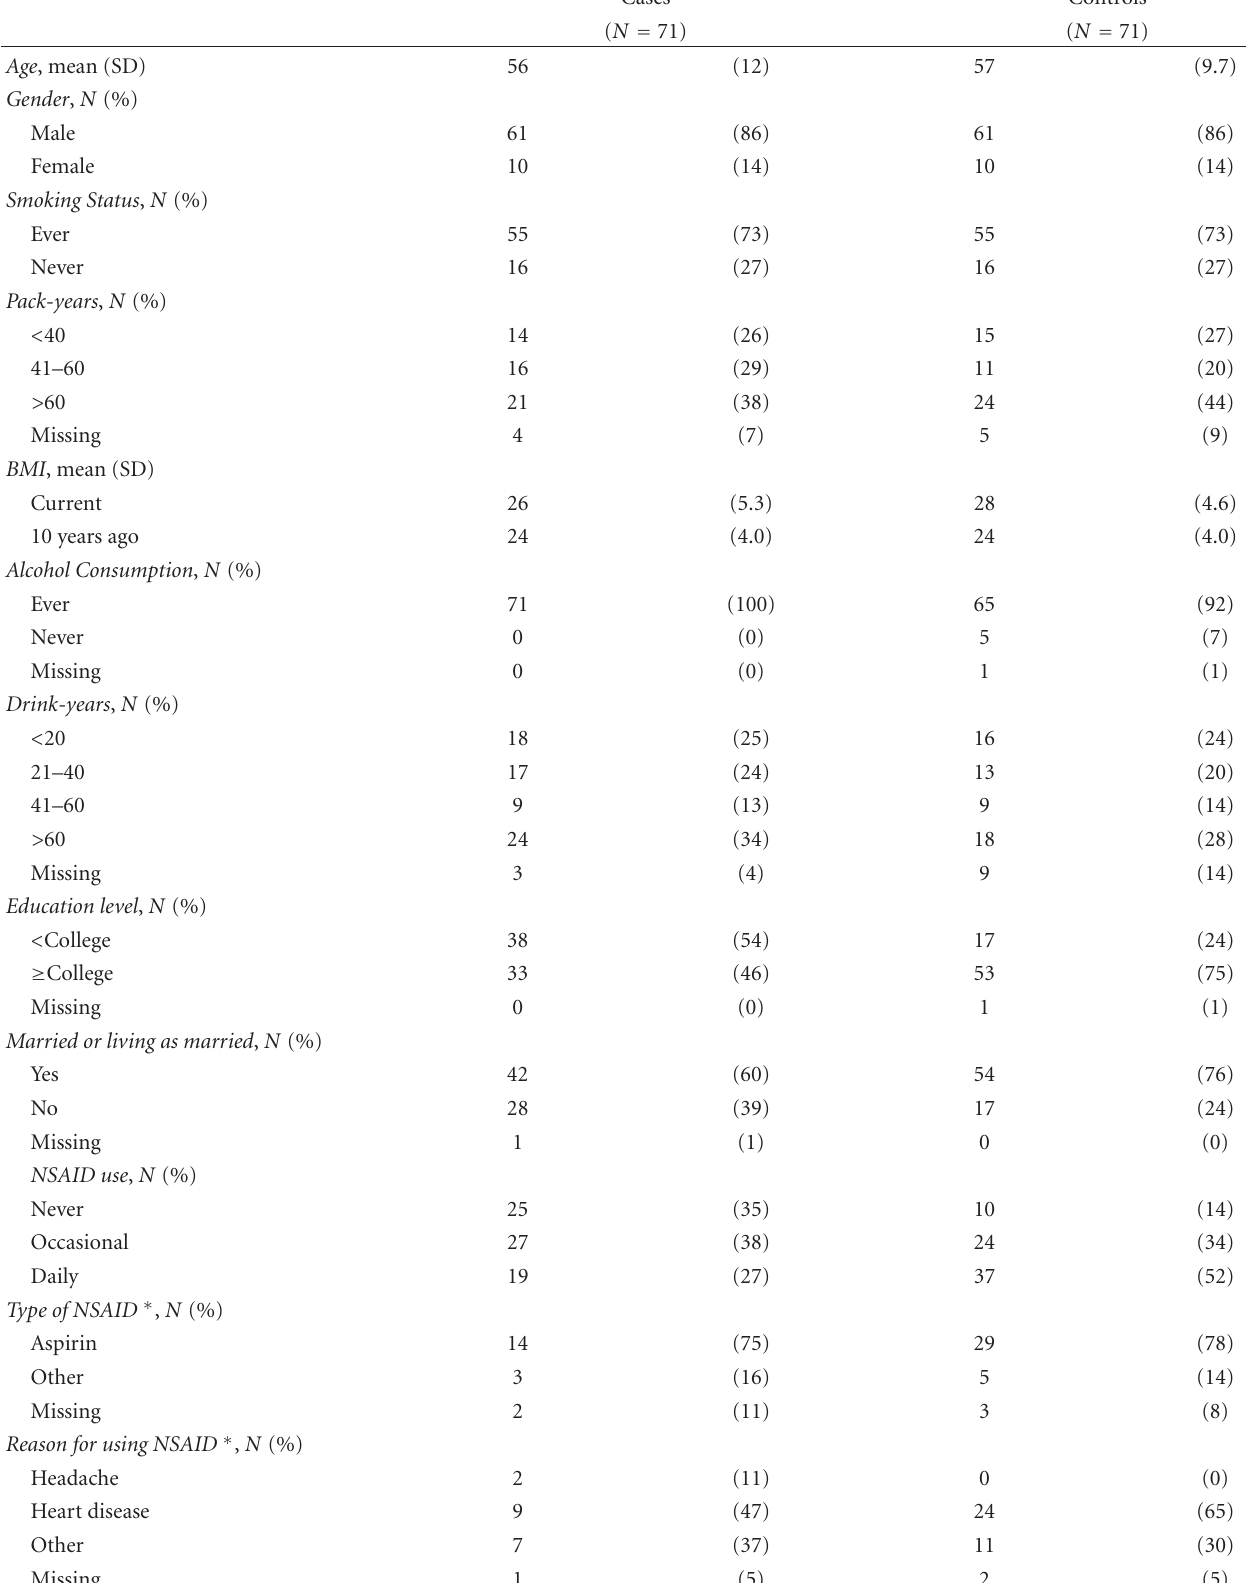
Table 1: Characteristics of patients with head and neck cancer and matched